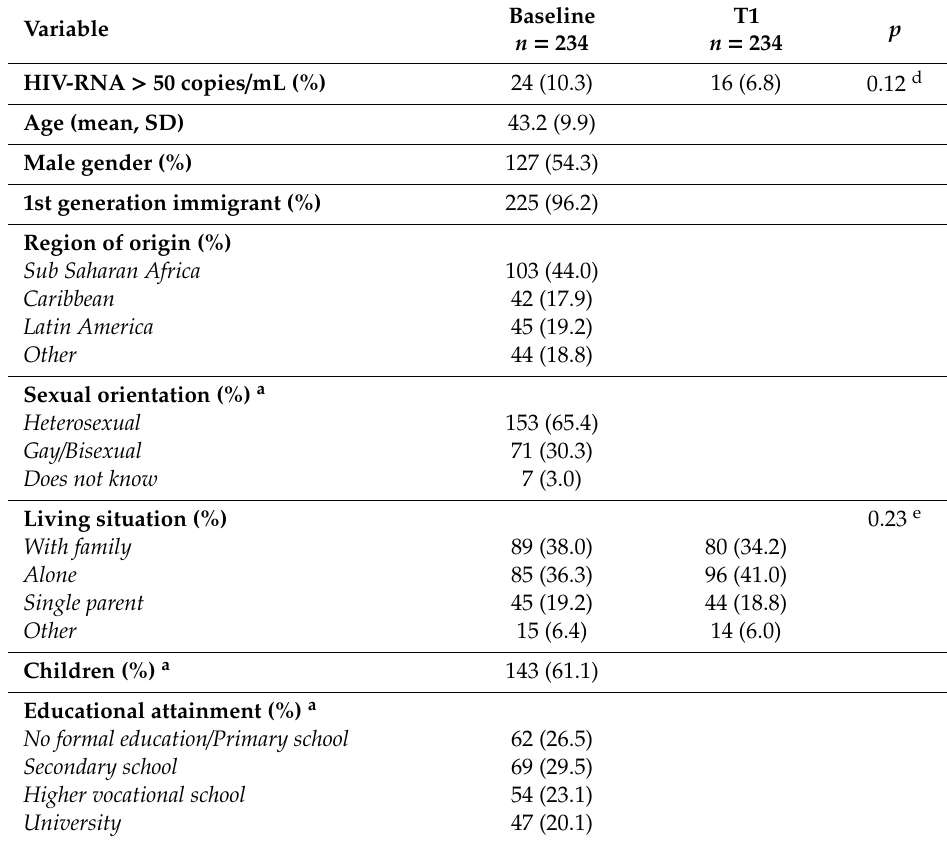
Figure 1. Patient inclusion ROtterdam ADherence (ROAD) Project. DAART, Directly Administered Antiretroviral Therapy; GMA, group medical appointments; HADS, Hospital Anxiety and Depression Scale. Table 1. Sociodemographic characteristics and psychosocial variables.